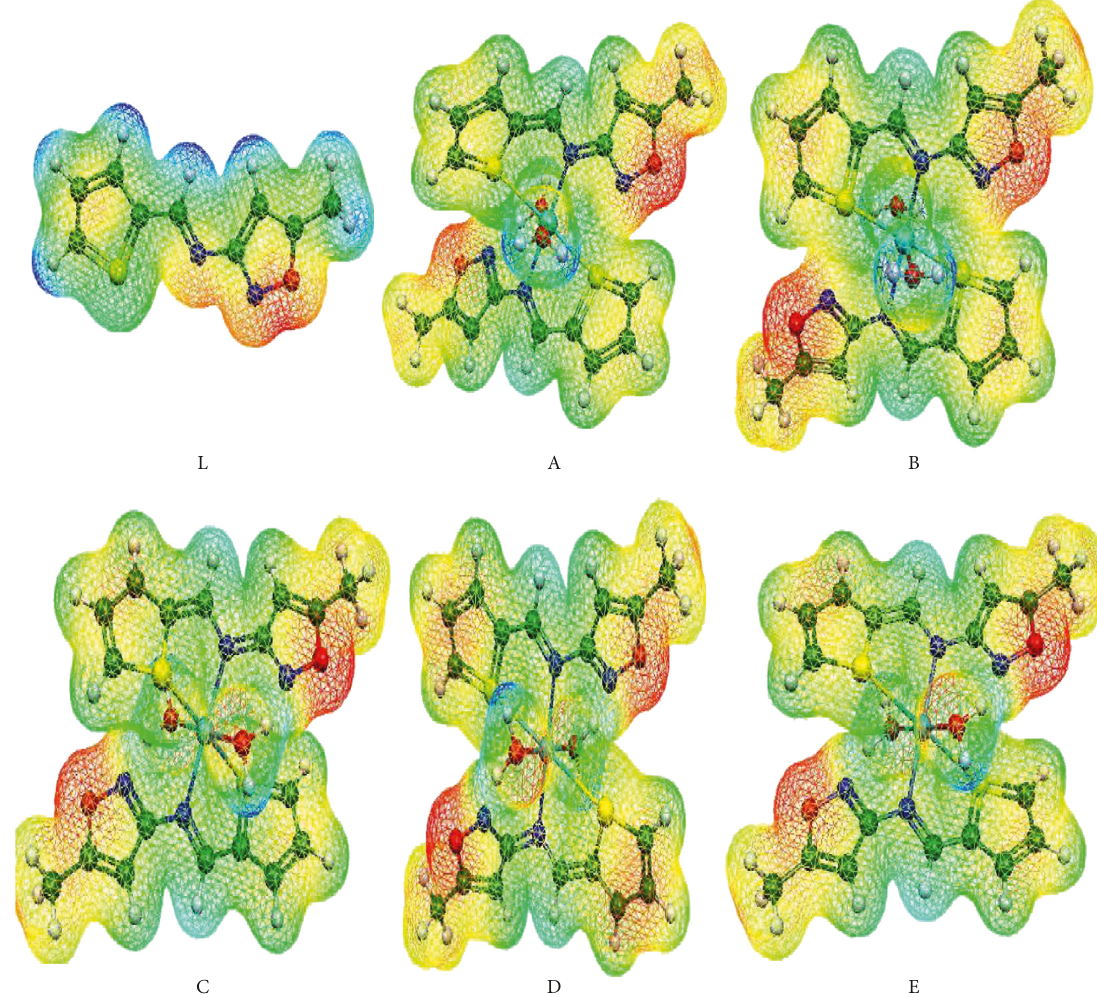
Figure 4: Calculated electrostatic potential surfaces for molecules studied. Regions of higher electron density are displayed in red and lower electron density in